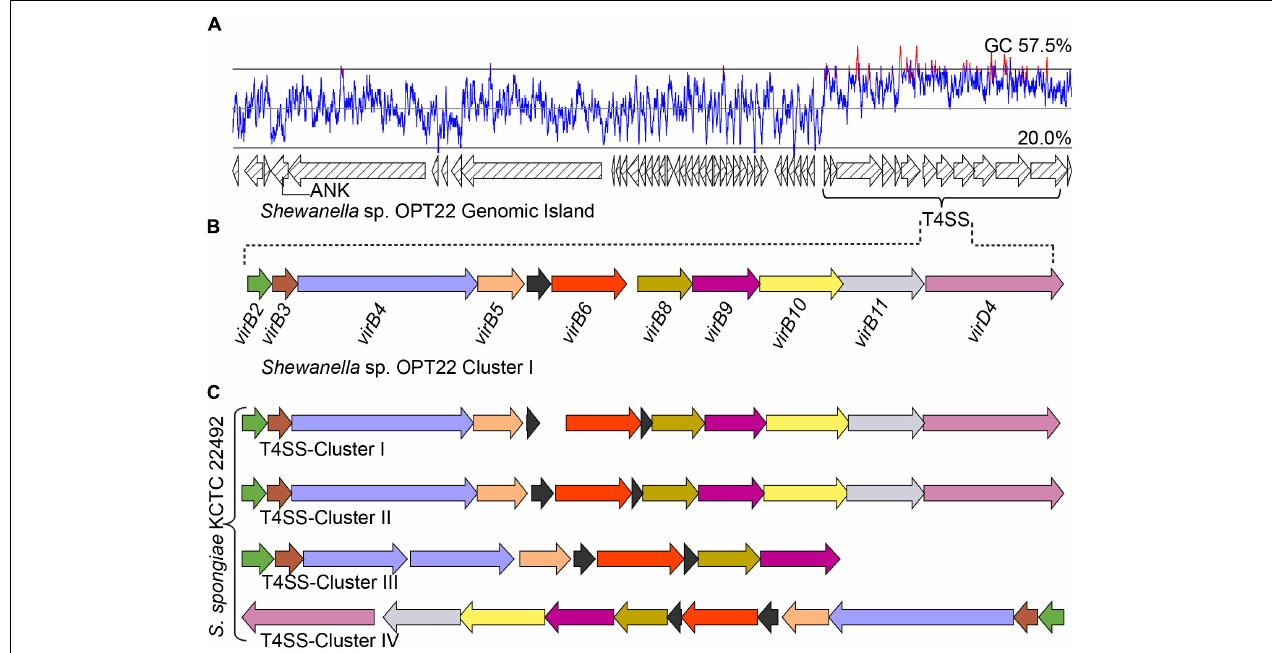
FIGURE 7 | Genomic island (GI) and type IV SS. (A) Predicted GI encoding T4SS gene cluster in Shewanella sp. OPT22. The line graph above the GI represents the GC content. A gene encoding for ankyrin-repeat containing protein is also shown. (B) Genetic organization of the type IV SS in Shewanella sp. OPT22 (cluster I). (C) T4SS gene clusters detected in S. spongiae KCTC 22492 (cluster I, II, III, and IV). Different color schemes are given for each predicted SS genes. Functionally related group of genes are indicated with the same color in each SS in both species. Black color denotes predicted hypothetical genes. The genes are not shown to